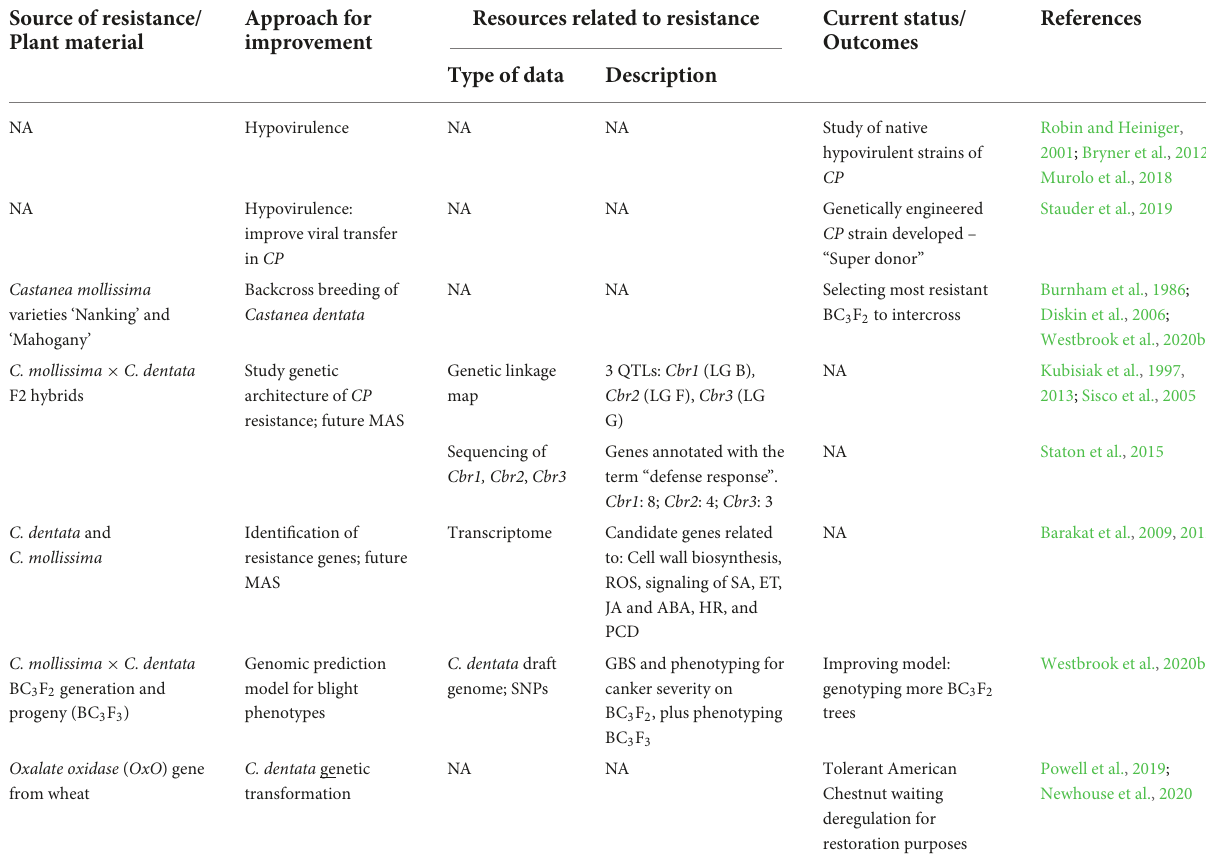
TABLE 1 Summary of efforts to control Cryphonectria parasitica ( CP